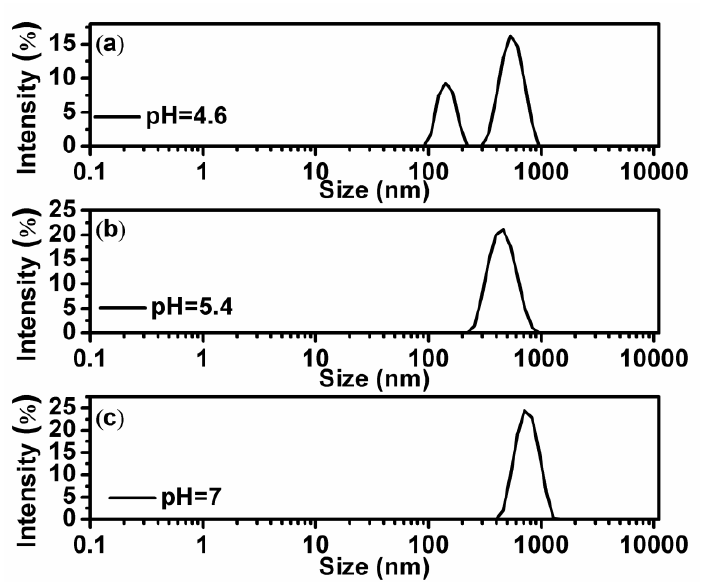
Figure 3. ( a – c ) are the size distribution of the DNA-chitosan complex at pH = 4.6, pH = 5.4, and pH = 7, respectively, with a fixed chitosan concentration of 0.2 µ M ( k = 1.9).